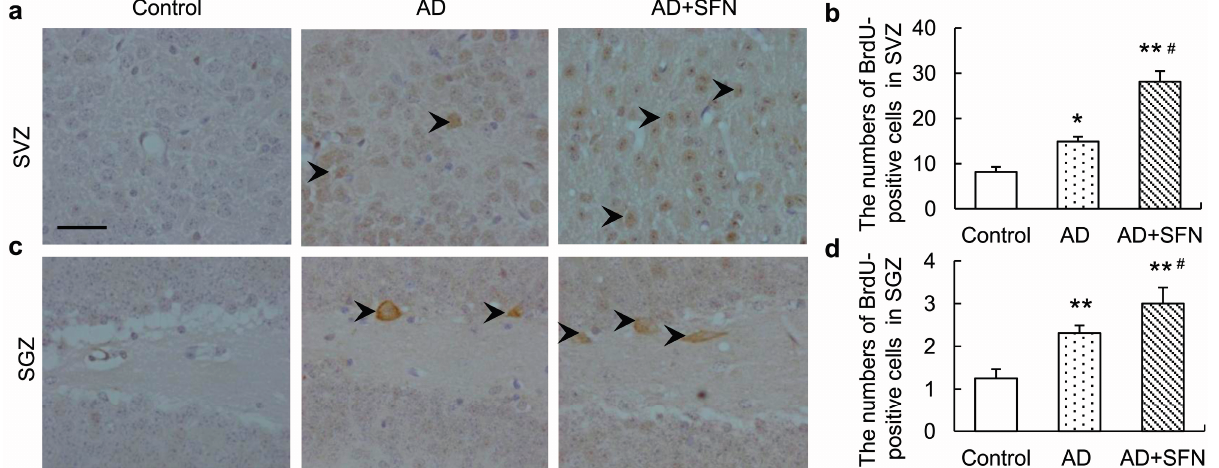
Figure 5. Immunohistochemistry assays of 5-bromo-2'-deoxyuridine (BrdU)-positive neurons in the subventricular zone (SVZ) and subgranular zone (SGZ). Brown immunoreactive cells imply the BrdU-positive neurons in mice brain (see arrows, bars = 100 μ m). Compared with controls, significantly more BrdU-positive cells were observed in the SVZ ( a ) and SGZ ( c ) of AD-like mice and AD + SFN-like mice. Moreover, sulforaphane significantly increased the numbers of BrdU-positive cells in the SVZ ( a ) and SGZ ( c ) of AD-like mice; ( b ) and ( d ) showed quantitative assessments of BrdU-positive cells in SVZ and SGZ, respectively. ( n = 8; means ± S.E.M.; One-way analysis of variance followed by post hoc least significant